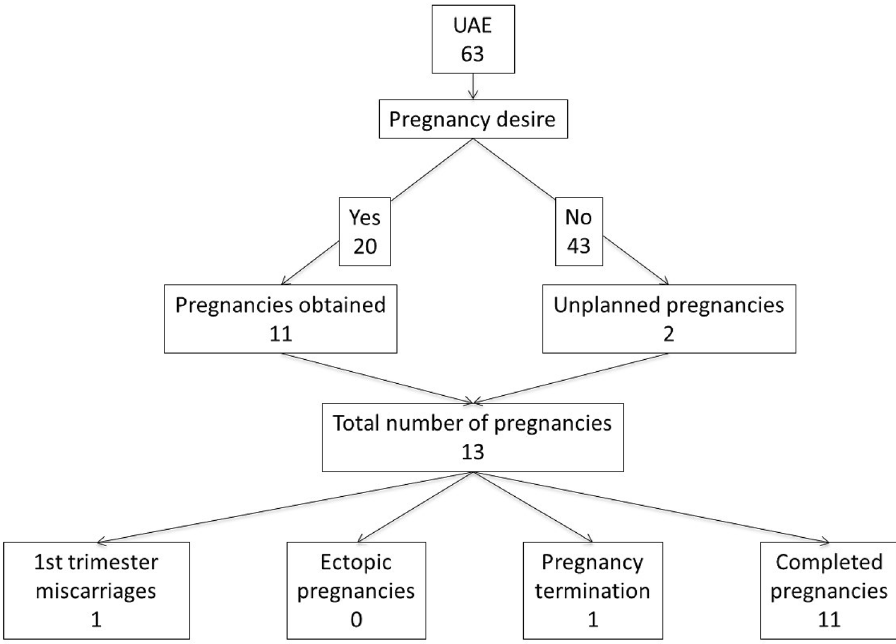
Figure 2. pregnancy desire and pregnancy outcomes of embolized patients (UAE).